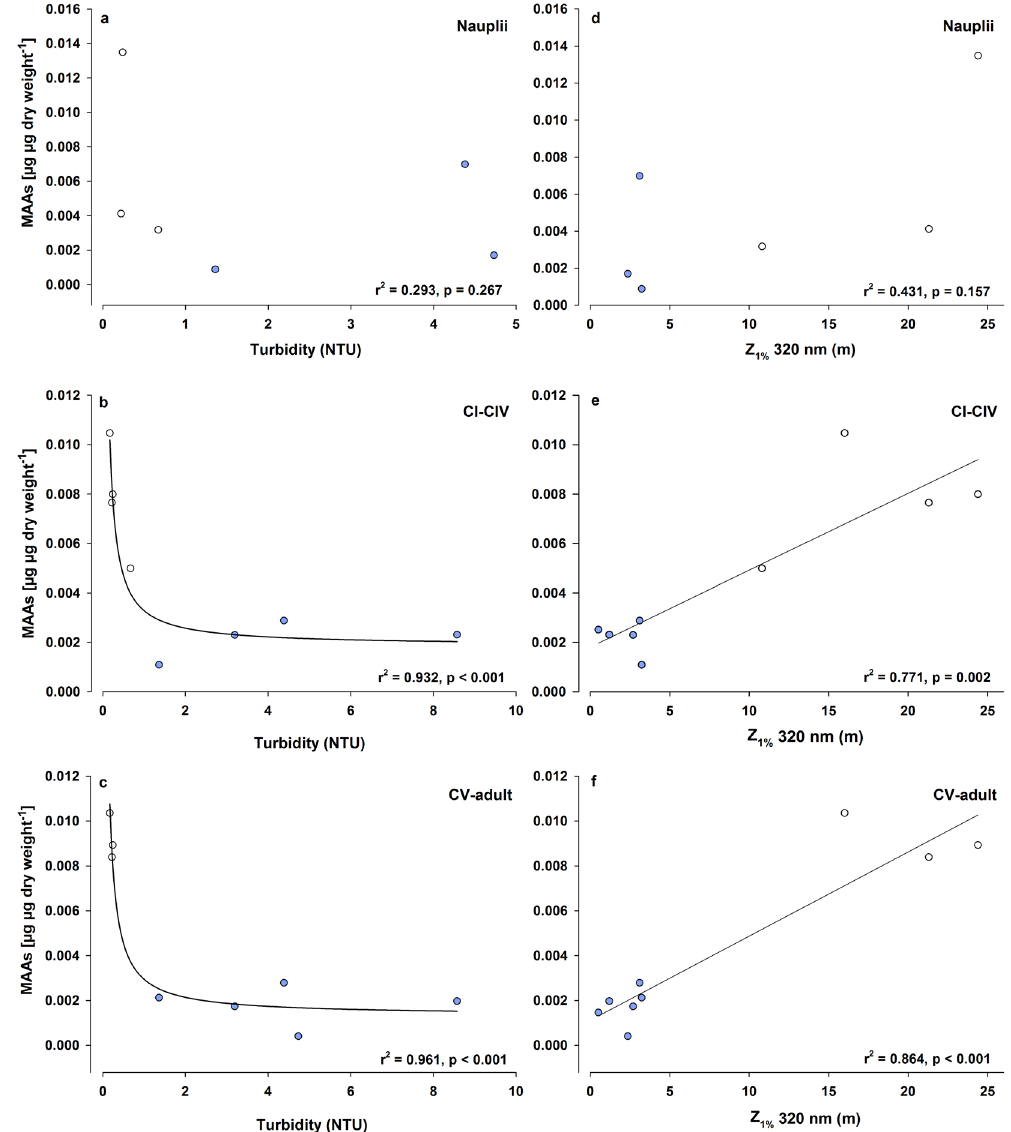
Figure 5. Relationship between total mean concentrations of MAAs ( µ g µ g dry weight − 1 ) in Cyclops abyssorum tatricus nauplii, copepodid stages CI-CIV, and copepodid stages CV to adult and the turbidity ( a – c ) and the 1% of the surface irradiance at 320 nm (Z 1%320 ) ( d – f ), respectively. Turbidity data are presented without Lake RIF. Open circles: clear lakes, closed circles: turbid